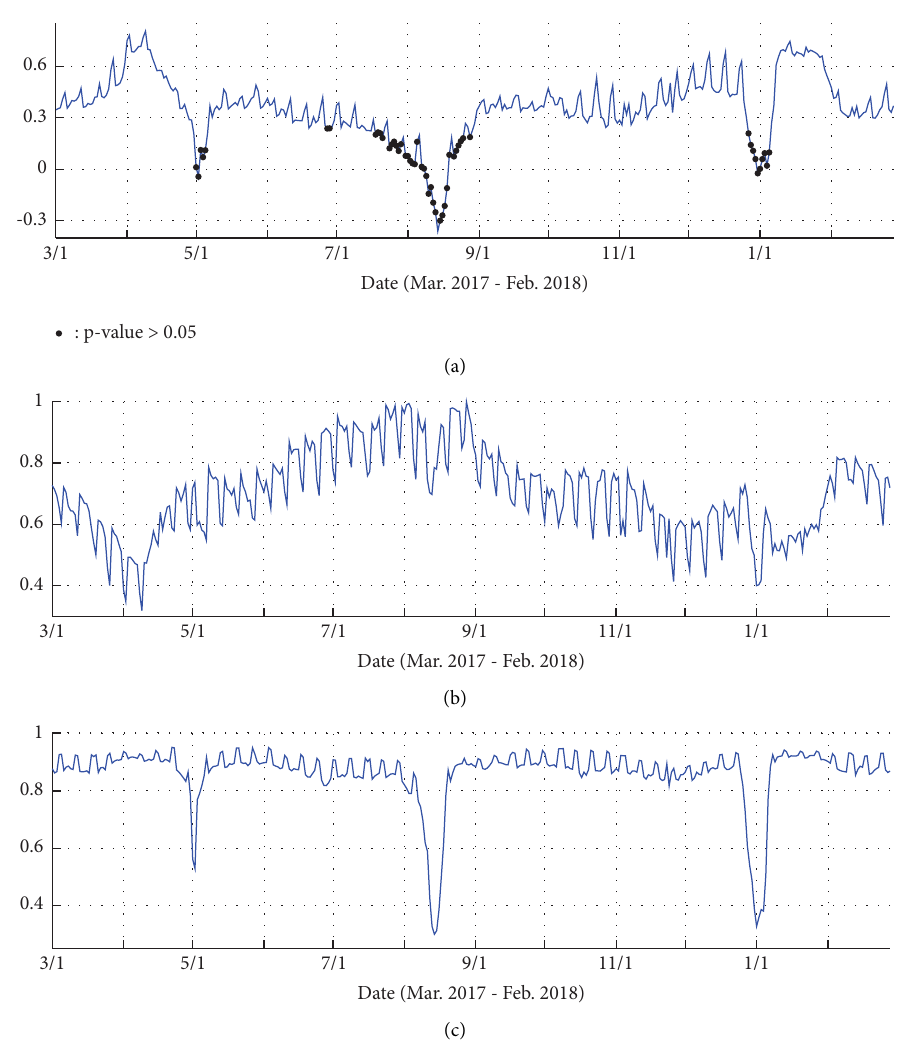
Figure 12: Regression analysis results for 365 days of destination amenities. (a) Estimated coefcients of ln (Population). (b) Estimated coefcients of ln (number of employees in the lodging industry). (c) R -squared